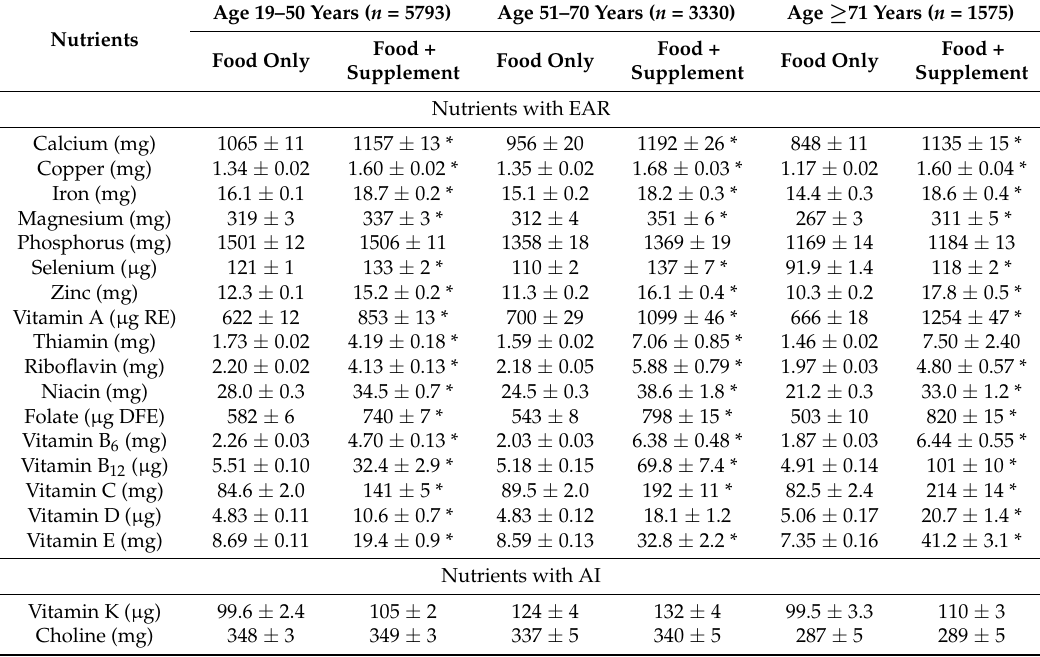
Table 3. Usual intake of nutrients from foods and foods + dietary supplements among adults (19+ years old) by age groups. NHANES 2009–2012, gender combined